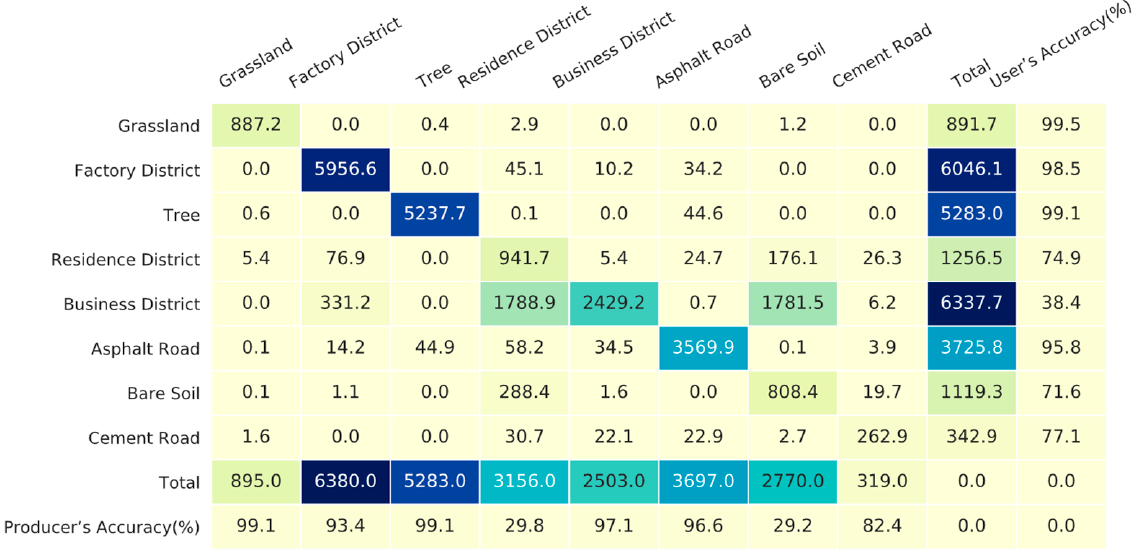
Figure 8. Confusion matrix of the classification results obtained when 32-angle images were se- lected as input data (representing the average values obtained in 10 iterations). Figure 9 shows the classification results obtained when 700-angle images were em- ployed, with 5% of the pixels utilized as the training set and the remaining 95% of the pixels employed as the testing set in the SVM classification method. We discovered that